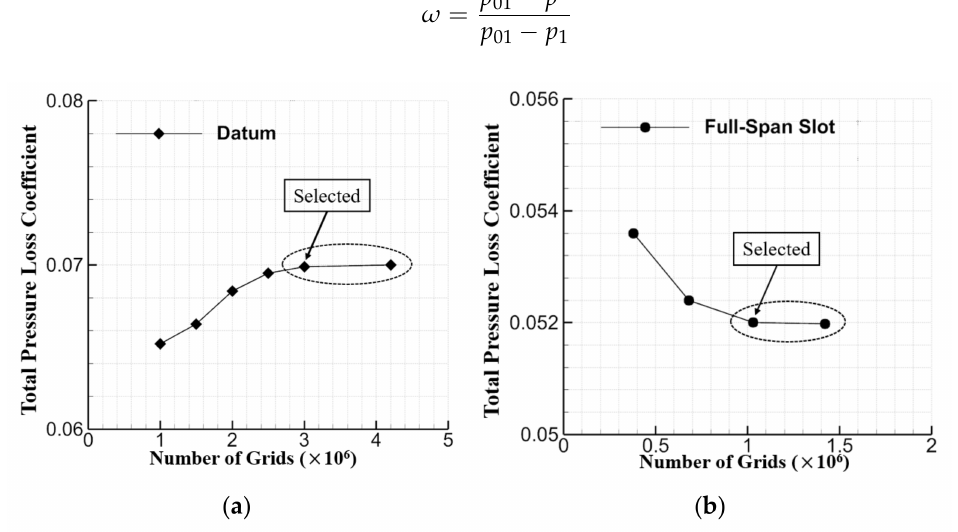
Figure 4. Grid independence validation: ( a ) datum cascade; ( b ) full-span slotted